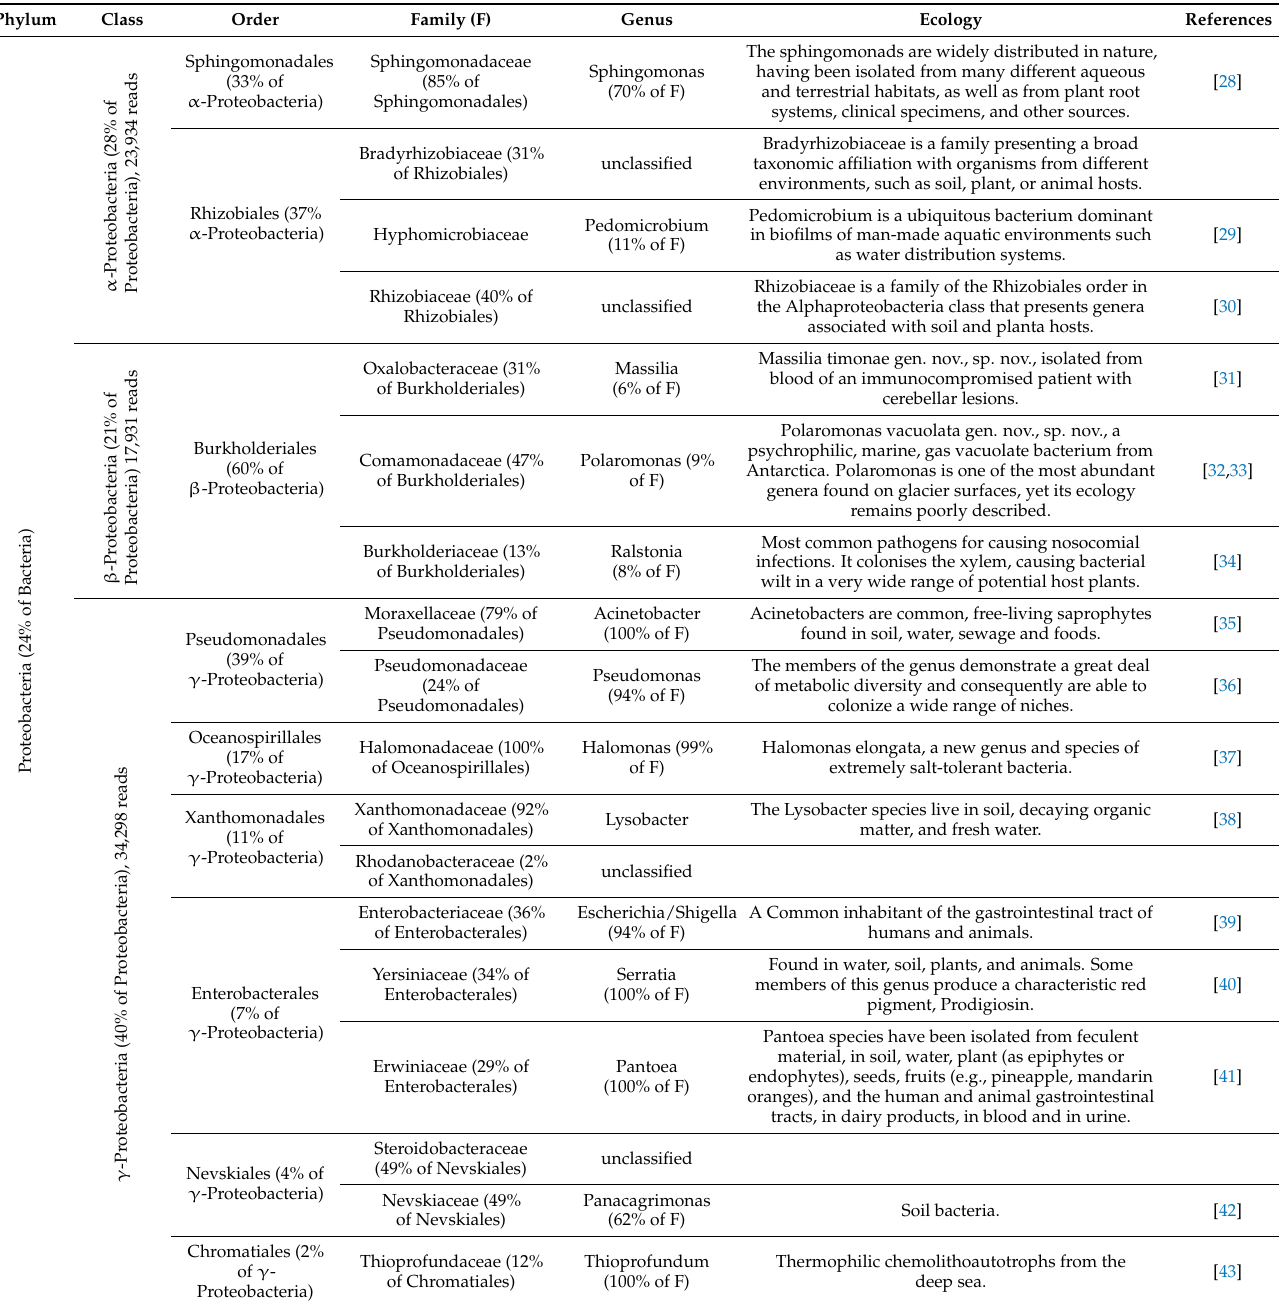
Table 1. The 18 families of Proteobacteria reported from the stalactite core sample and their environmental origin.